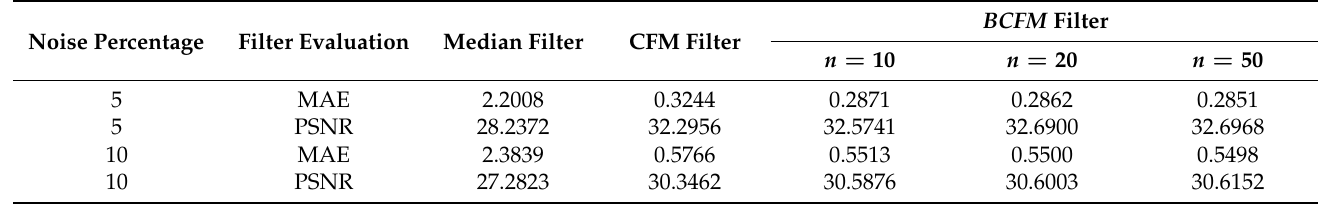
Table 2. Comparison of the performance of the noise reduction filters for the Lenna image.